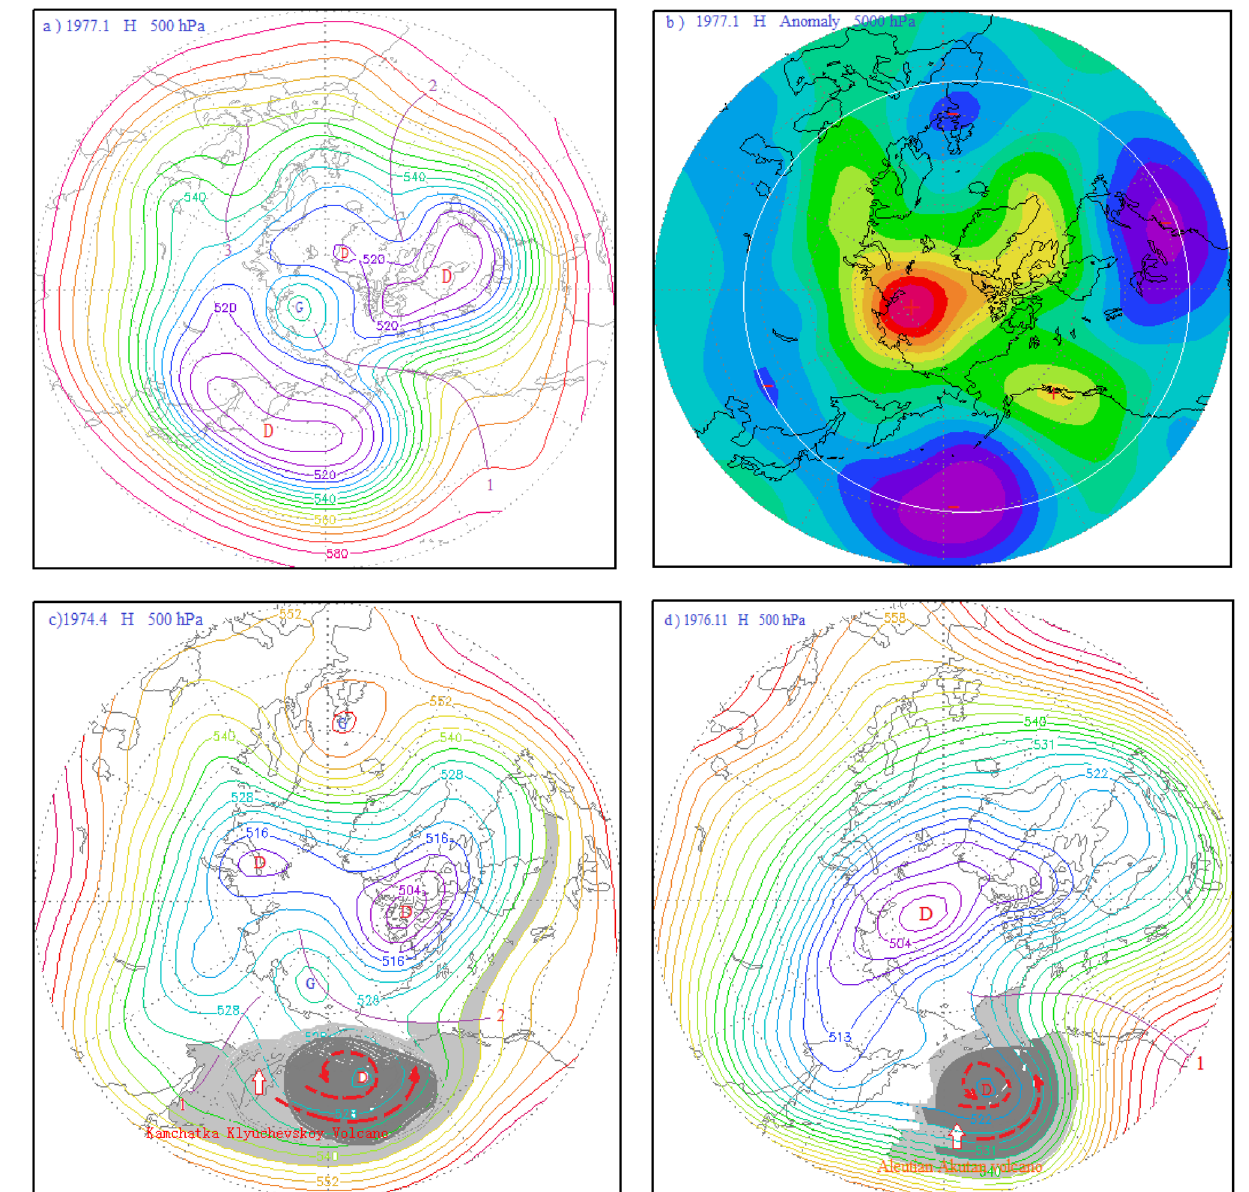
Figure 9. ( a ) Atmospheric circulation characteristics of the 500 hPa layer from 30 to 90° N in January 1977; ( b ) potential height field anomaly distribution of the 500 hPa layer from 30 to 90° N in January 1977; ( c ) 500 hPa atmospheric circulation characteristics and distribution diagram of volcanic dust curtain and aerosol layer in mid-high latitudes of the Northern Hemisphere in April 1974; ( d ) schematic diagram of the atmospheric circulation characteristics of the 500 hPa layer from 40 to 90° N and distribution of the volcanic dust curtain and aerosol layer in November tion in front of the vortex is conducive to the further strengthening of the Pacific-North American ridge toward the Arctic region. This causes the isobaric surface of the Arctic region to rise. As shown in Fig. 9b, the Arctic region was controlled by a positive geopotential height anomaly, while a negative geopotential height anomaly zone existed in the middle and high latitudes around the Arctic region. A blocking high was present in the Arc- tic region, with the Great Lakes vortex and East Asian-Aleutian vortex surrounding the Arctic region. A strong anti-oscillation event was generated in which the atmospheric pressure in the Northern Hemisphere fell in the middle and high latitudes and rose in the Arctic region. In addition, the Kamchatka Klyuchevskoy Volcano erupted on April 8, 1974, although this eruption occurred outside the Arctic vortex circulation and under the subsiding diffuse flow ahead of the high pressure ridge, as shown in Fig. 9c. It is also apparent that a vortex had formed near the Aleutian Islands, and the volcanic dust and aerosol layer from the eruption circulated within the vortex. Hence, the amount of outward diffusion was small, and the effect on the center of the Arctic vortex was small.